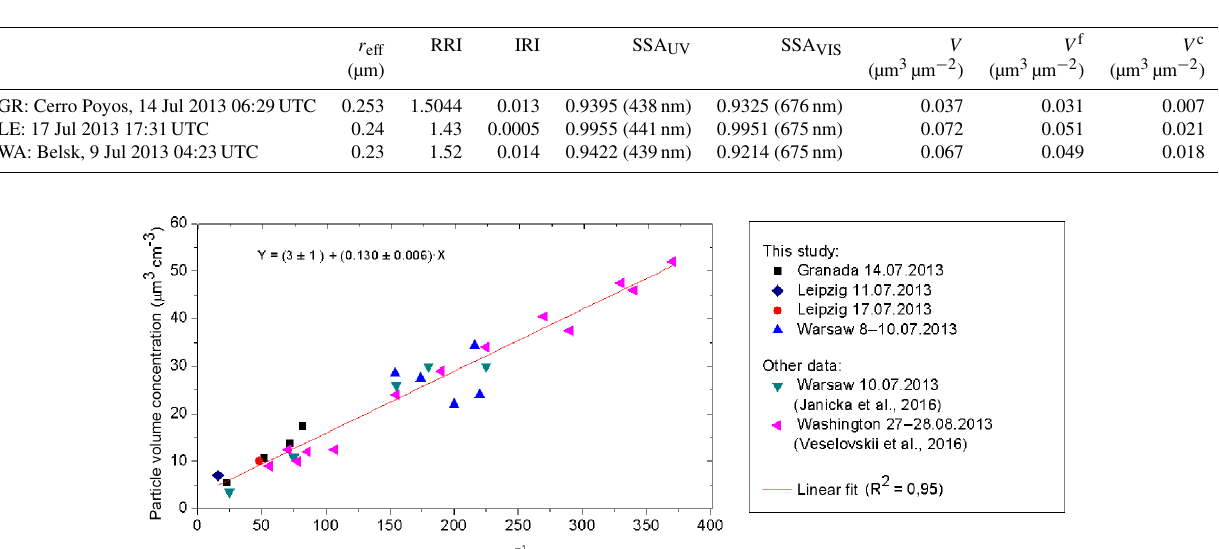
Table 6. Columnar microphysical properties retrieved from AERONET inversions, which are the nearest in space and time to the analyzed lidar Raman measurements.